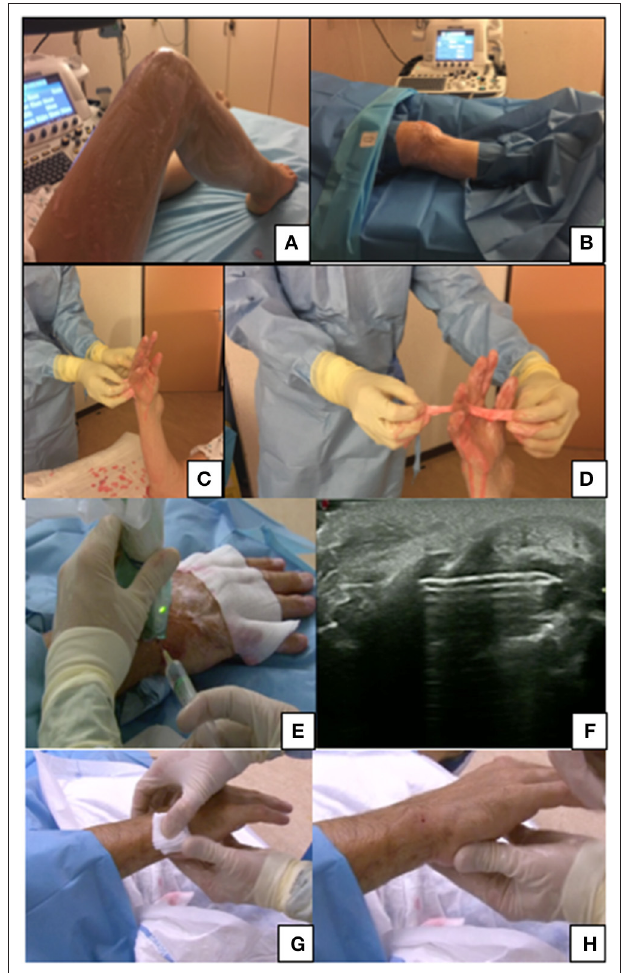
FIGURE 2 | (A,B) Preparation for knee biopsy, patient lying. (C,D) Hand washing before a biopsy of wrist/PIP with a focus on the interdigit region washing. (E,F) Articular anesthesia after skin anesthesia with 18G 50mm needle under ultrasound guidance. (G,H) Post-procedure care, a 2min compression of the hole entrance before putting a small